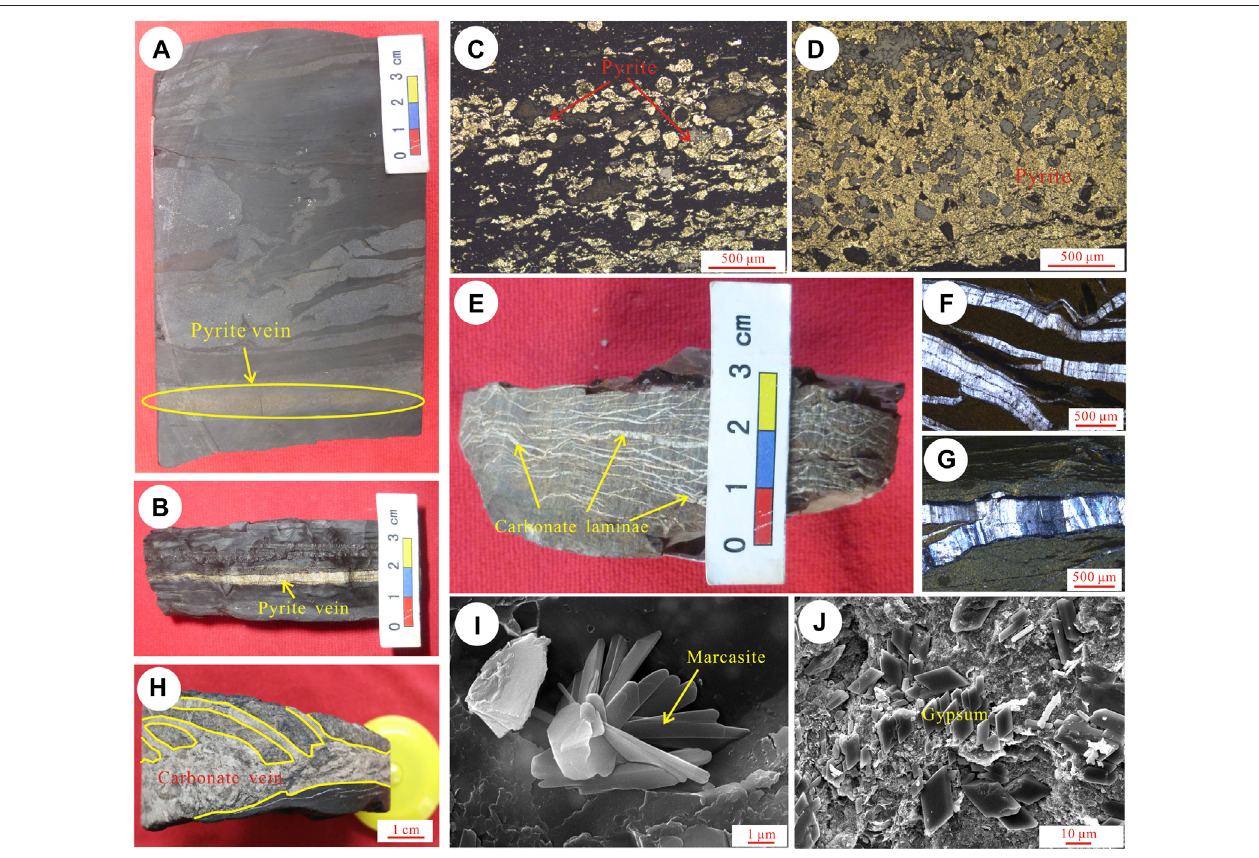
FIGURE 4 | Photographs of minerals in the Chang 7 black shale of the Ordos Basin (A) Pyrite vein, Well L57, 2350.13 m; (B) Pyrite vein, Well X36, 2188.58 m; (C,D) Microscopic characteristics of pyrite vein in photo B; (E) Carbonate laminae, Well W100, 1907.05 m; (F,G) Microscopic characteristics of carbonate laminae in photo E; (H) Carbonate vein characterized by branches, Well Y56, 3065.24 m; (I) Marcasite, Well Z62, 1938.00 m; (J) Gypsum, Well Y423, 2402.17 m.